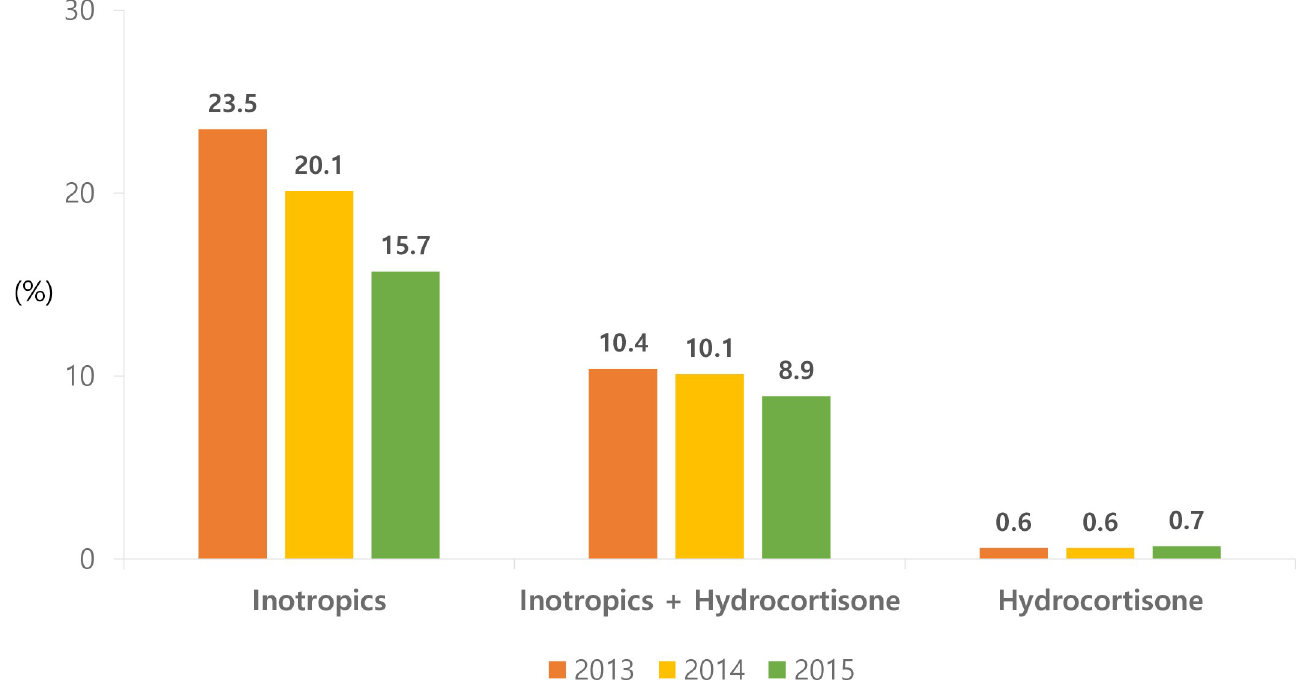
Fig 2. The proportion of the use of each hypotensive drug within the first postnatal week in VLBWI, 2013–2015.